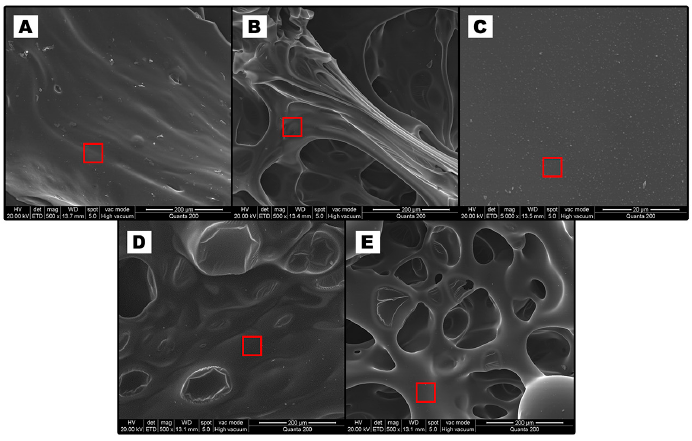
Figure 11. SEM images of different layer in the char residue of EP-2 after cone calorimeter test. The red squares indicate the scanning areas of EDS measurement. Table 5. EDS results of the layered char of EP-2 after cone calorimeter test.